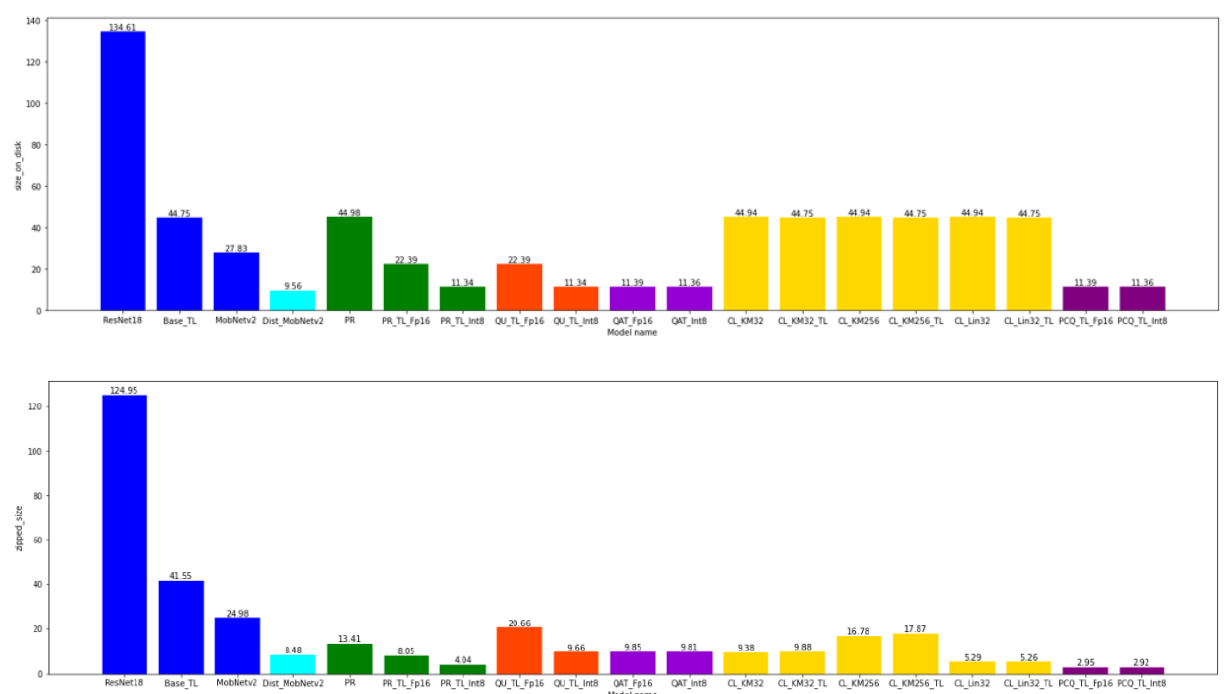
Figure A7. The comparison of the model accuracies and the comparison of the model execution time.